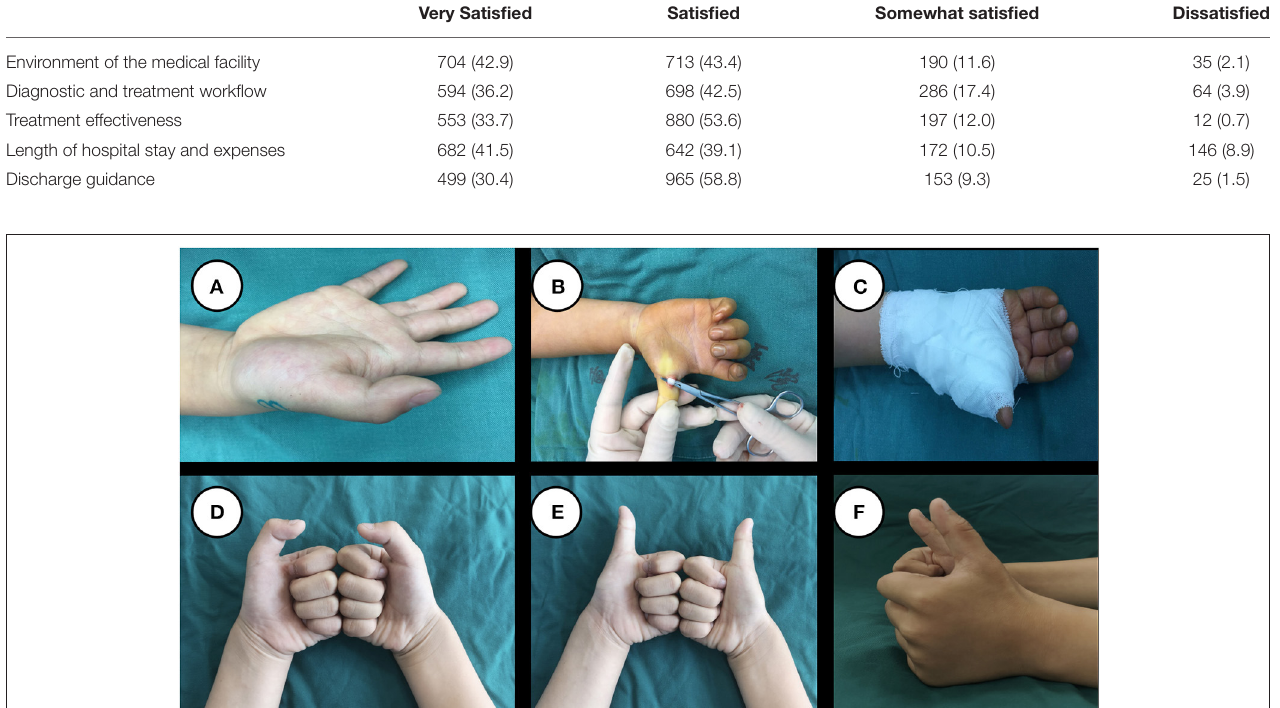
FIGURE 2 | A 3-year and 5-month-old boy presented with inability to extend his right thumb for 4 months. Before the operation, extension of the interphalangeal joint of the thumb was limited (A) . A1 pulley release was performed. After the tendon sheath was released, the motion of the interphalangeal joint of the thumb returned. The tendon glided well without entrapment and with a normal ROM (B) . The incision was closed with sutures, and the thumb was immobilized in the dorsal extension position (C) . A follow-up visit at 1 year and 9 months after the operation showed a well-healed incision, no obvious scar formation, normal appearance of the thumb, and unrestricted movement of the interphalangeal joint of the thumb, frontal view of the thumb in flexion (D) , frontal view of the thumb in straight position (E) and side view of the thumb in straight position (F)